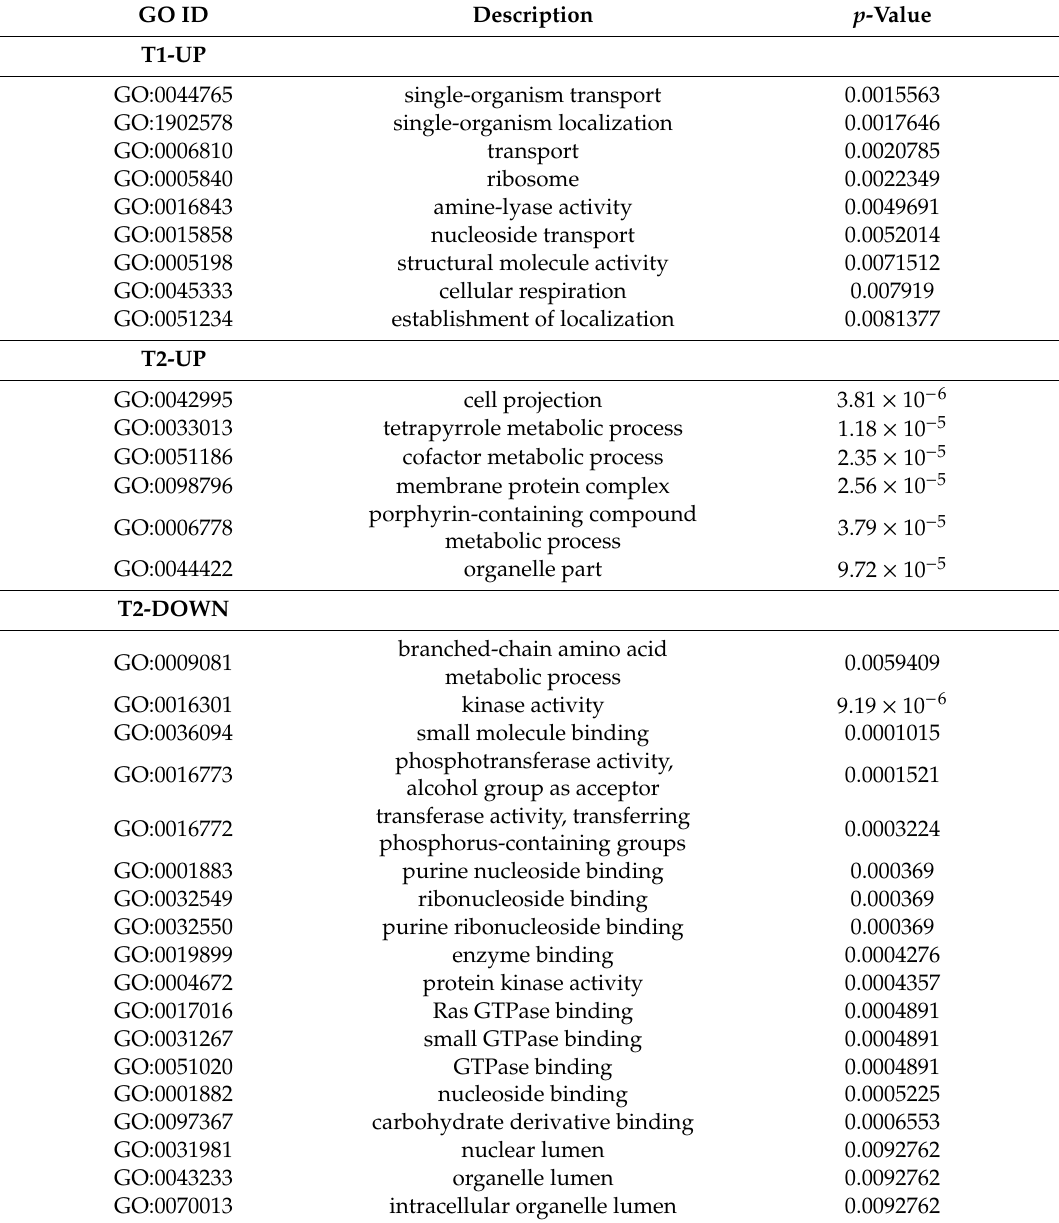
Table 2. Results of Gene Ontology (GO) enrichment